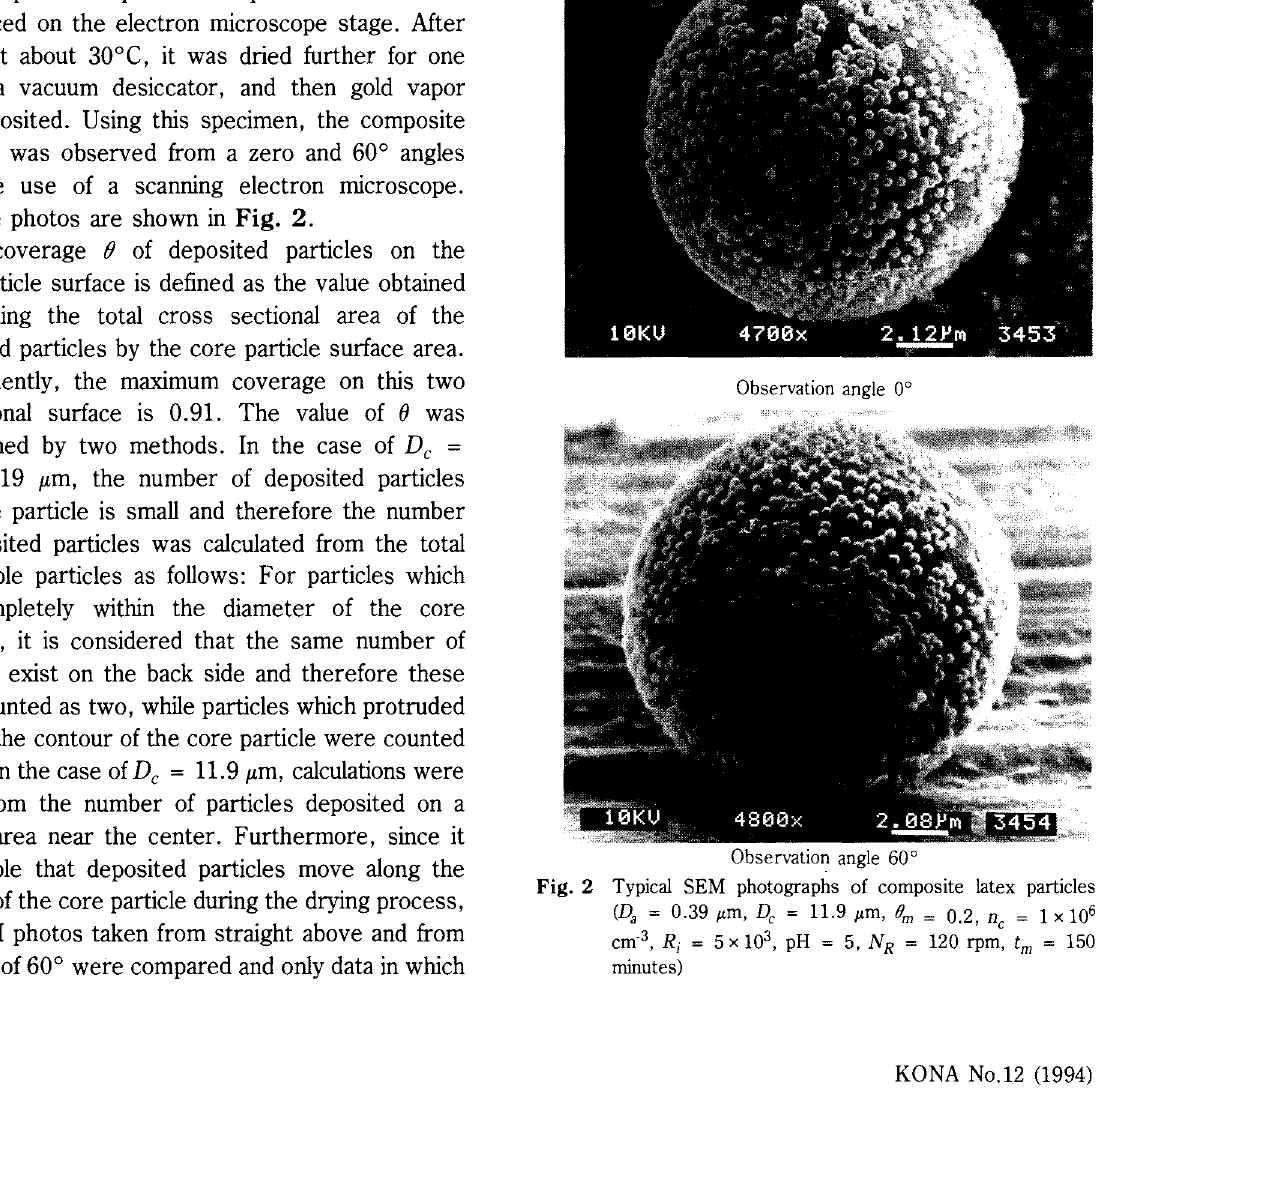
Fig. 1 Dependence of .t-potential of employed particles on pH